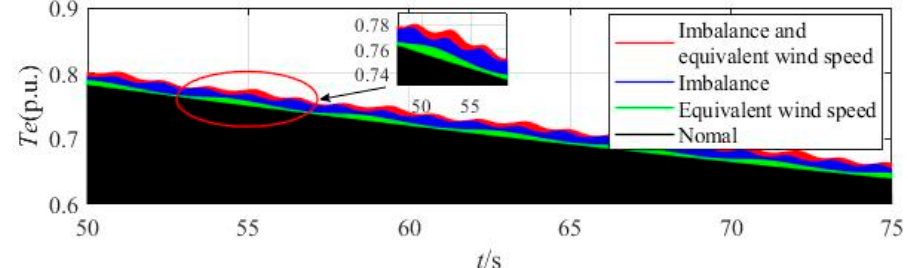
Figure 8. Electromagnetic torque time-domain waveform.